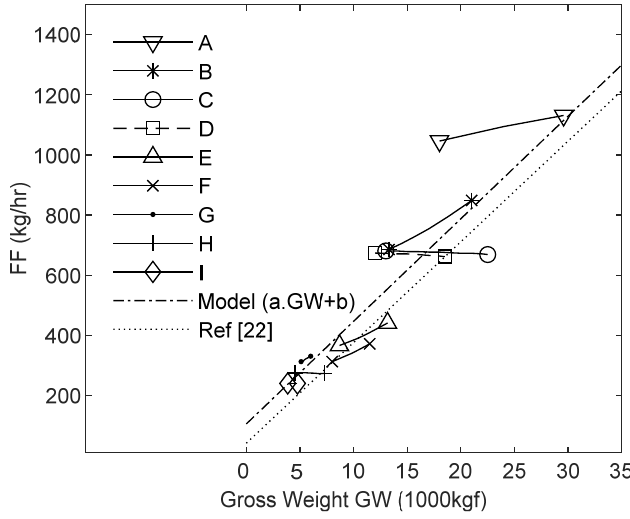
Figure 6. Hourly fuel flow and gross weight dependence at constant altitude.